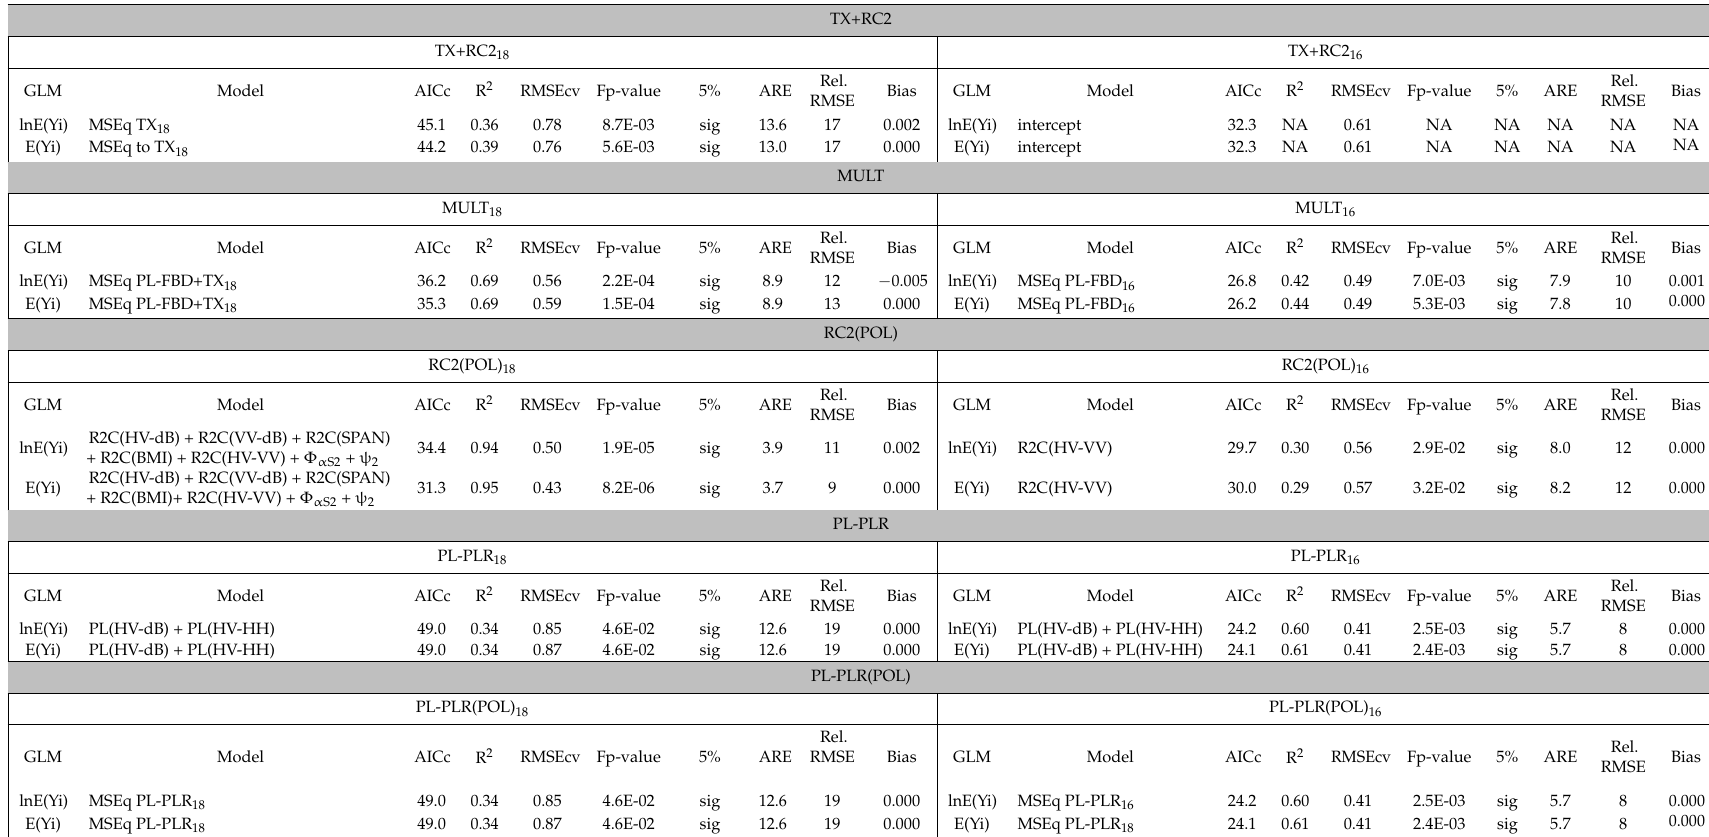
Table 4. Generalized Linear Model (GLM) specifications and model evaluation for predicting Leaf Area Index from synthetic aperture radar data in floodplain forests of the Amazon